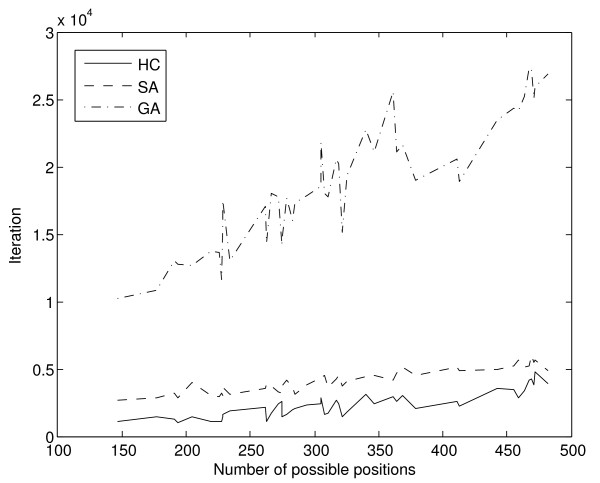
Mean convergence per experiment, according to search space size. As in Figure 6, Figure 7 represents the mean convergence per method and experiment. However, in this case experiments are represented in an ordered fashion, from the one with least expressed multi-membership genes, and smallest search space to the one with most expressed multi-membership genes and largest search space.